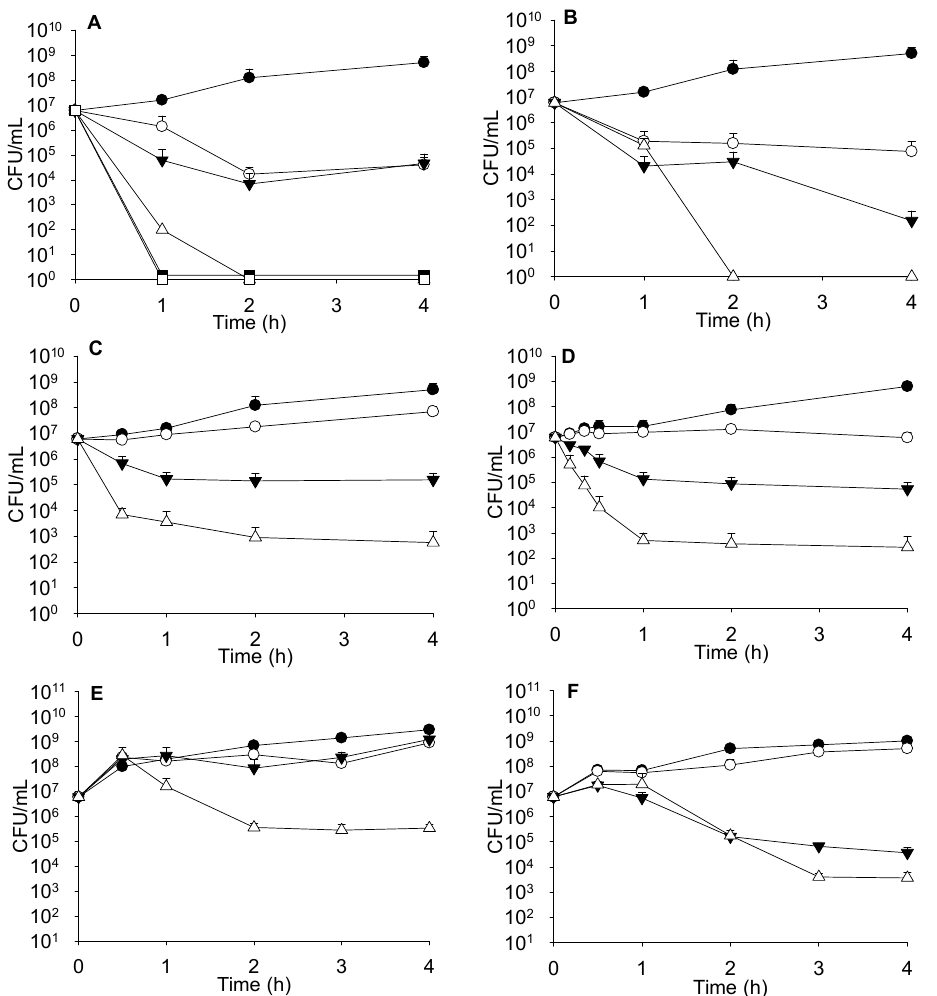
Figure 2. Antibacterial activity of colistin sulphate (COL), imipenem (IMI), meropenem (MER) and AMP38 in different combinations. ( A ) ATCC strain; Control (filled circles), IMI 4 μ g/mL (open circles), COL 0.5 μ g/mL and IMI 4 μ g/mL (filled triangles), COL 4 μ g/mL (open triangles), COL 4 μ g/mL and IMI 0.5 μ g/mL (filled squares), COL 4 μ g/mL and IMI 4 μ g/mL (open squares); ( B ) PA116136 strain; Control (filled circles), COL 0.25 μ g/mL and IMI 32 μ g/mL (open circles), COL 2 μ g/mL and IMI 4 μ g/mL (filled triangles), COL 2 μ g/mL and IMI 32 μ g/mL (open triangles); ( C ) PA116136 strain; Control (filled circles), IMI 4 μ g/mL (open circles), AMP38 8 μ g/mL (filled triangles), AMP38 8 μ g/mL and IMI 4 μ g/mL (open triangles); ( D ) PA116136 strain; Control (filled circles), MER 1 μ g/mL (open circles), AMP38 8 μ g/mL (filled triangles), AMP38 8 μ g/mL and MER 1 μ g/mL (open triangles); ( E ) 536SJD strain; Control (filled circles), IMI 4 μ g/mL (open circles), AMP38 2 μ g/mL (filled triangles), IMI 4 μ g/mL and AMP38 2 μ g/mL (open triangles); ( F ) 481SJD strain; Control (filled circles), IMI 4 μ g/mL (open circles), AMP38 4 μ g/mL (filled triangles), IMI 4 μ g/mL and AMP38 4 μ g/mL (open triangles).